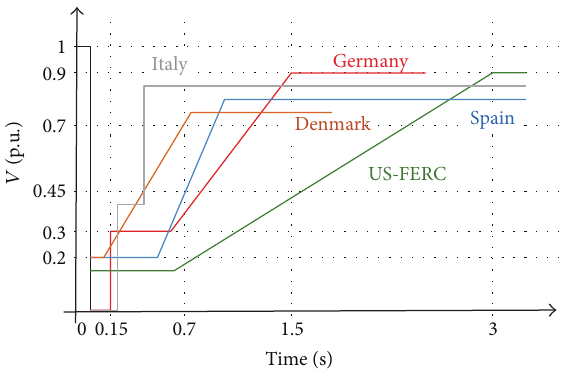
Figure 1: Low-voltage ride-through (LVRT) requirements of Dis- tributed Generation systems in different countries [2, 5].